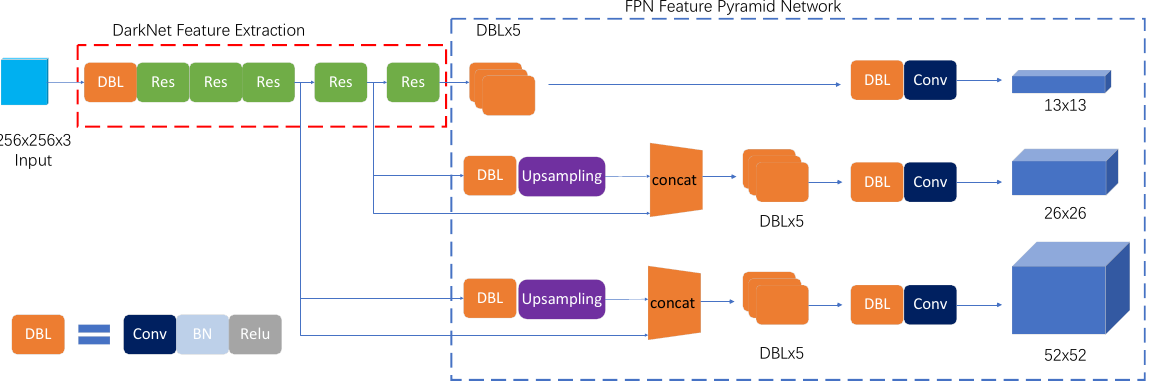
Figure 3. The baseline map of Sentinel-1 images.